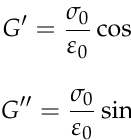
Figure 16. Elastomer structures: ( A ) is an unstressed polymer; ( B ) is the same polymer under stress.